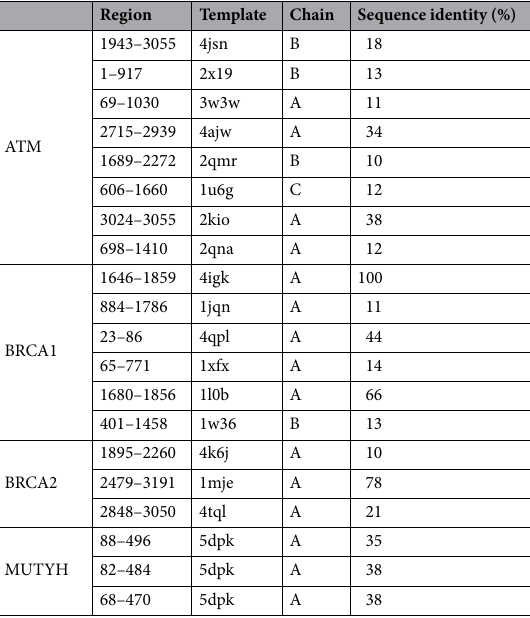
Table 6. List of 3D models annotated in the ModBase